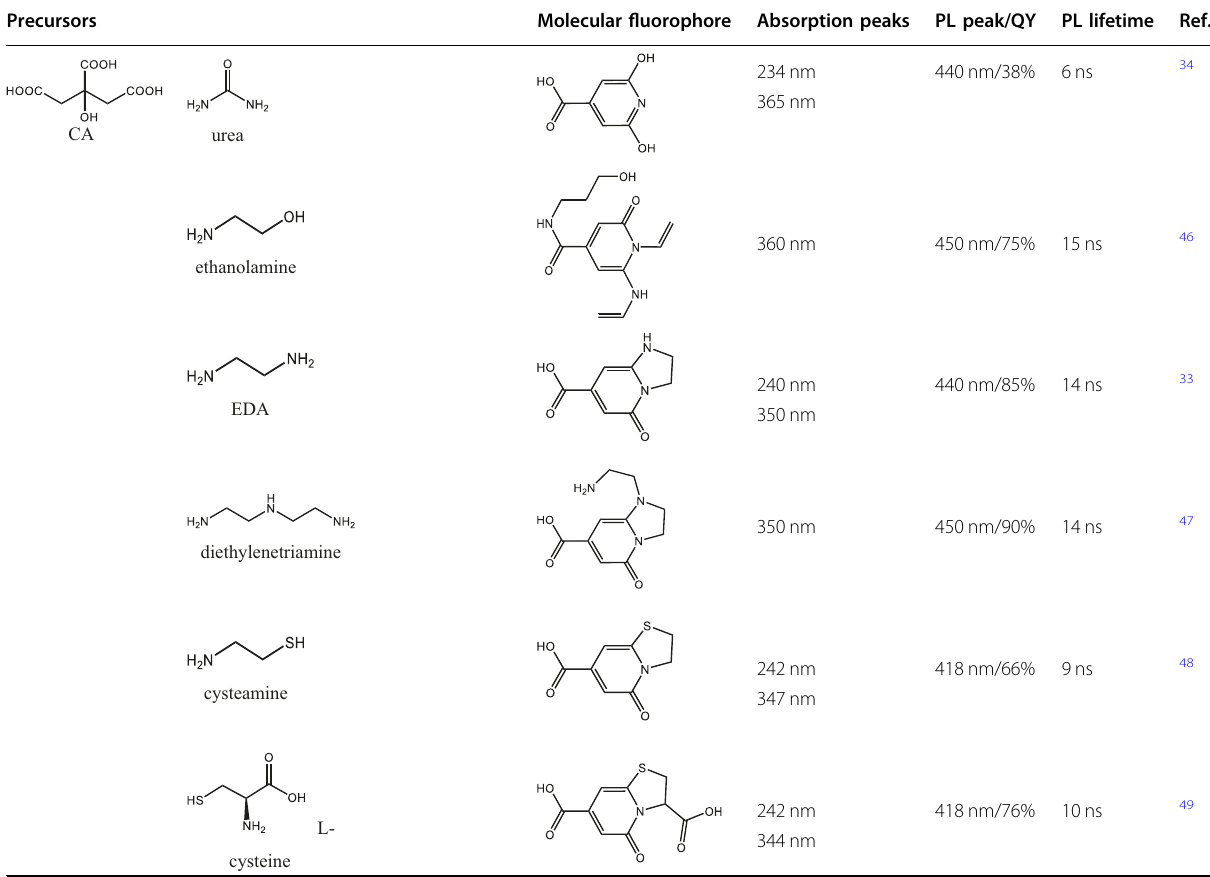
Table 1 Chemical structure and optical properties of molecular fl uorophores in CA-based CPDs.